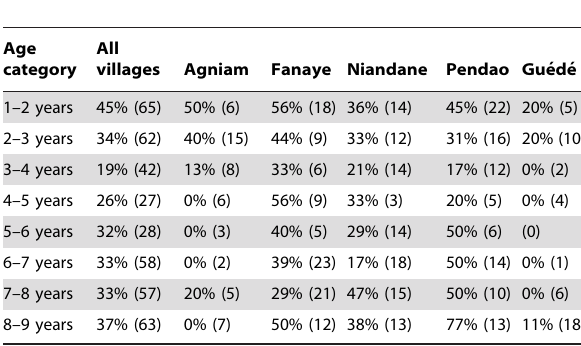
Table 3. PT-IgG . 30 IU/ml at T1 according to age categories and villages.